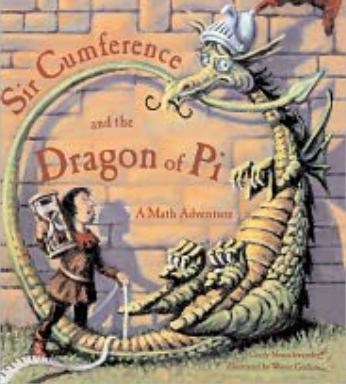
Figure 1. Book Cover